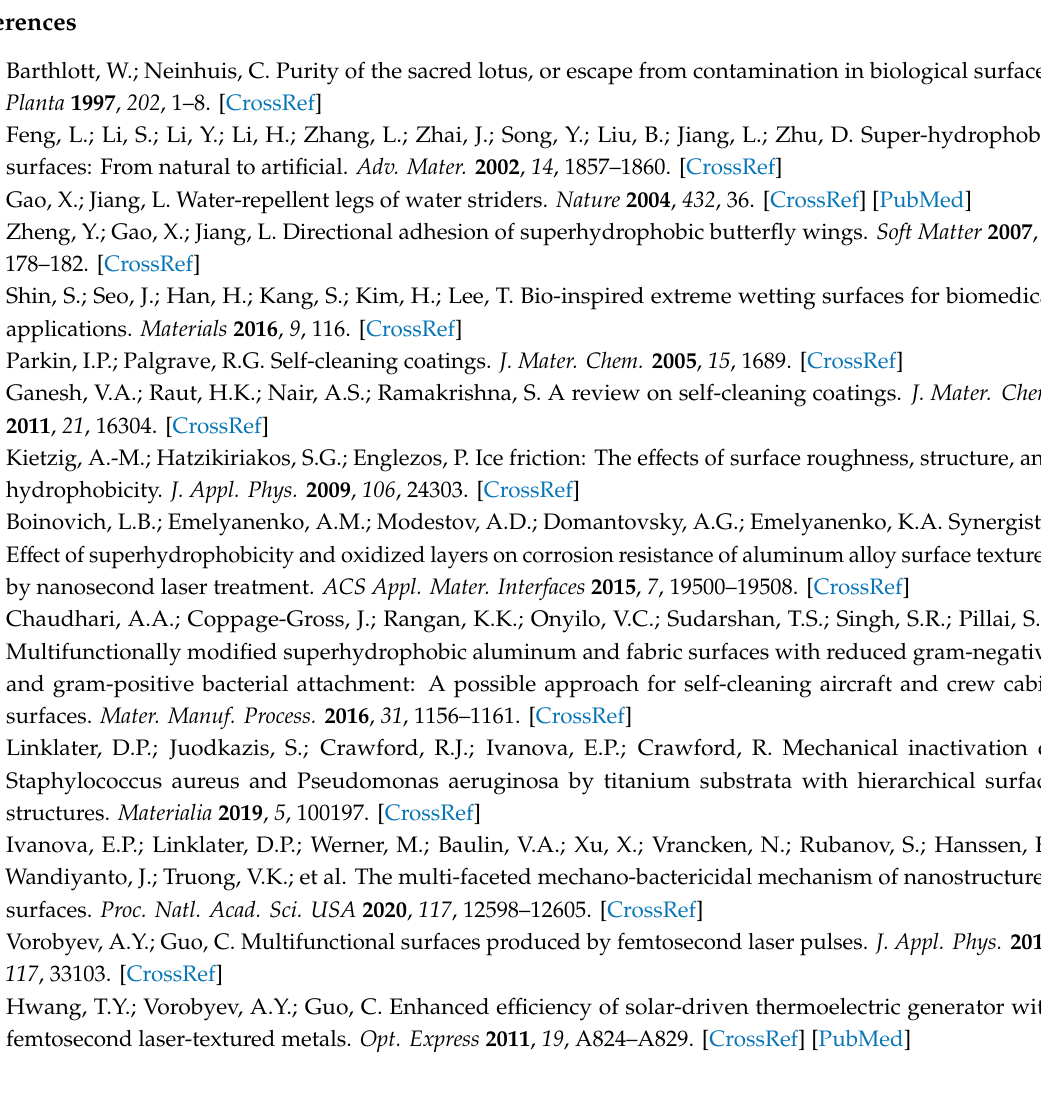
Figure A7. C 1s spectra of unstructured sample 1 and 14 days after preparation. No solvent was used for